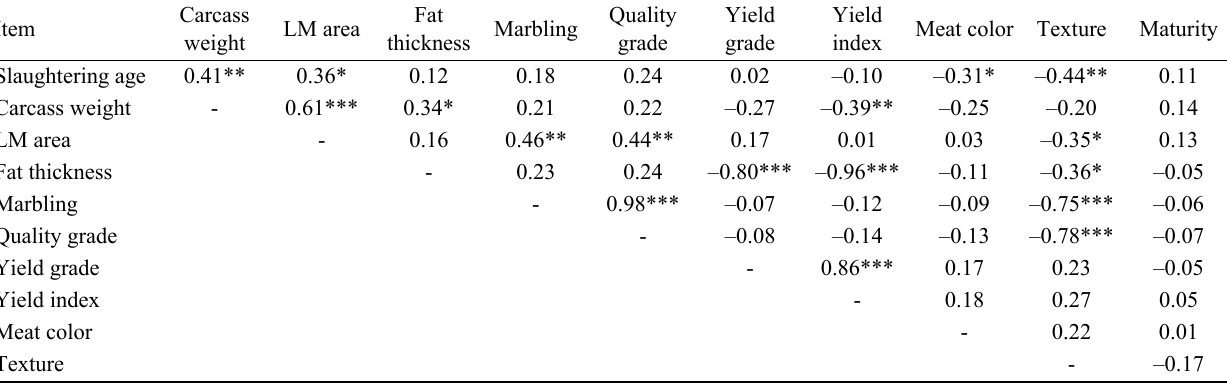
Table 9. Pearson correlation coefficients between carcass traits and physico-chemical characteristics of loin in Korean cattle steers Item